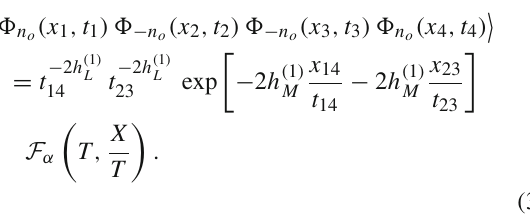
Fig. 2 Boosted intervals A 1 and A 2 in a GCFT 1 + 1